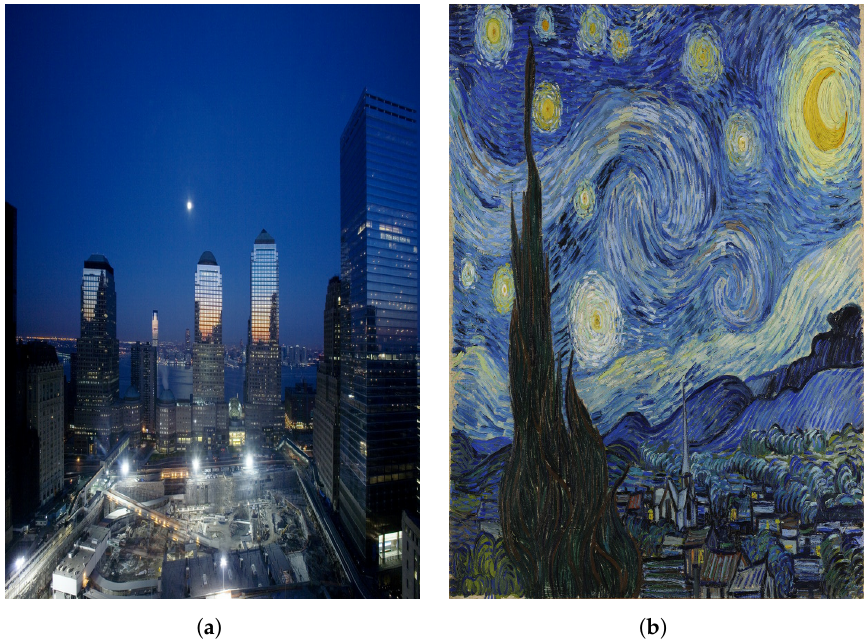
Figure 8. A set of images for the style transfer. ( a ) A content image. ( b ) A style